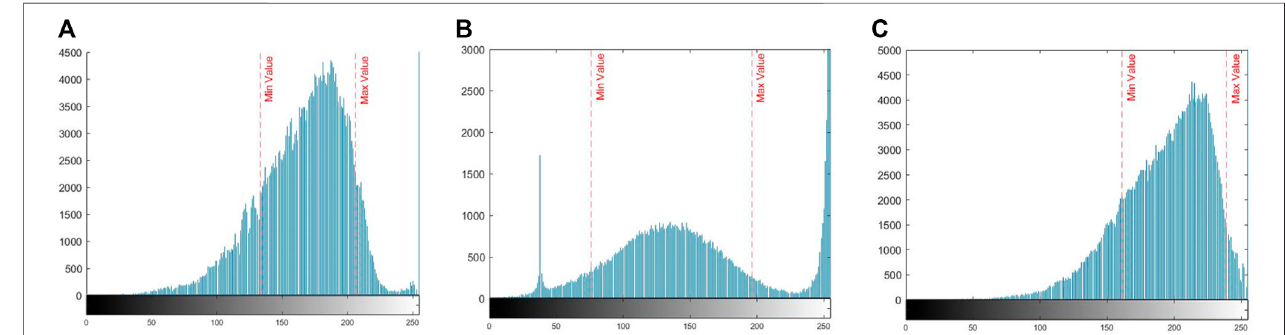
FIGURE 7 | Histograms corresponding to Figure 4A,E,C mosaics, Cabbage, Small cabbage, Red cabbage.